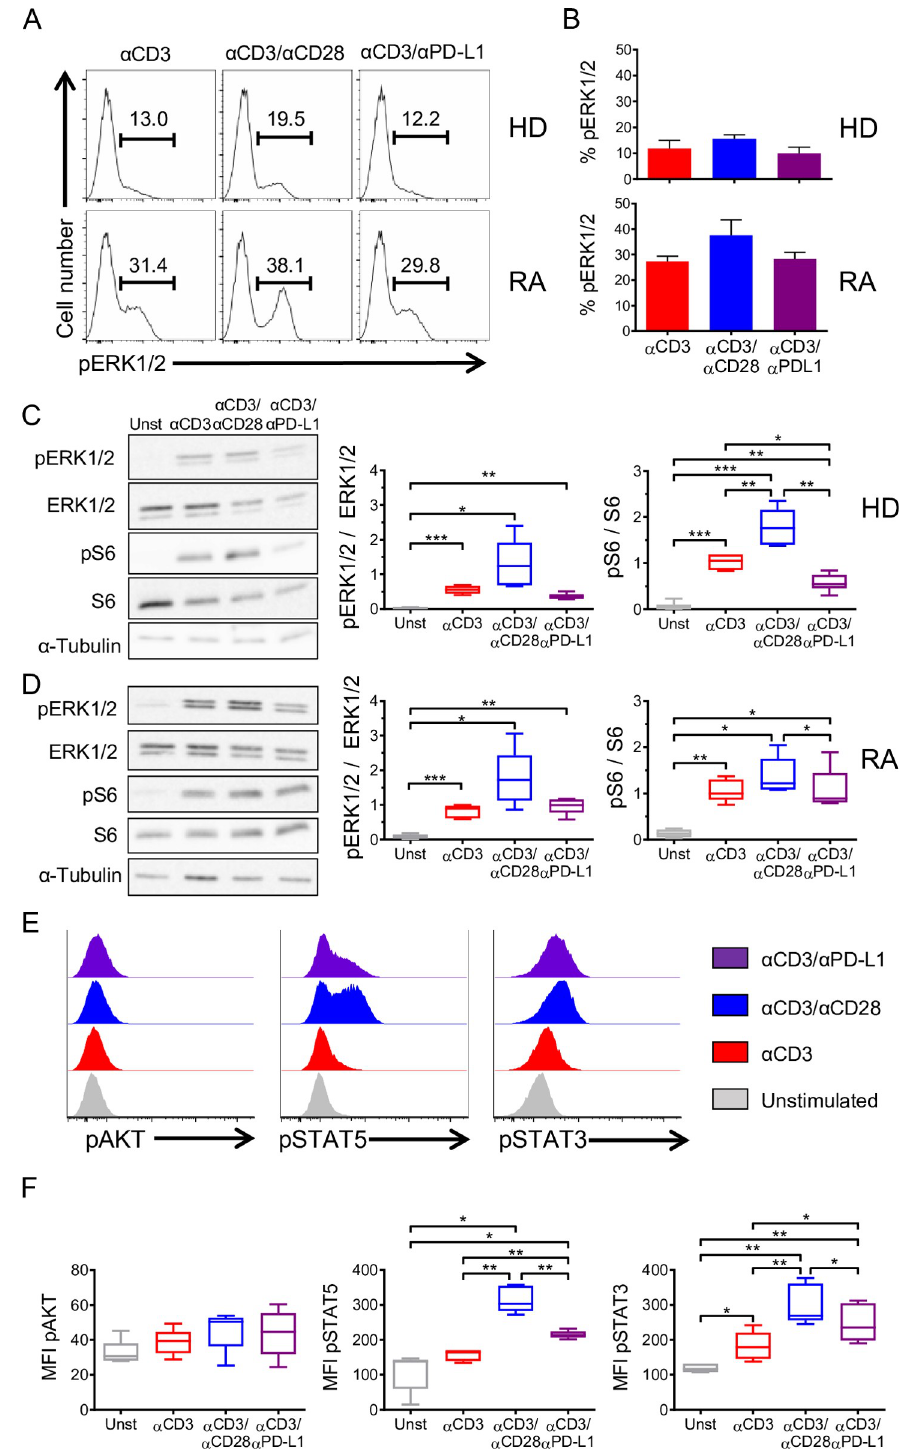
Fig 6. PD-L1 engagement fails to convert CD4 + CD25 − T cells from RA patients into iTreg cells. Representative flow cytometry histograms ( A ) and bar charts ( B ) showing the percentage of pERK1/2 in HDs and RA patients upon the indicated stimulation. ( C ) Representative immunoblot of pERK1/2, ERK1/2, pS6, and S6 in CD4 + CD25 − T cells isolated from HDs upon 15 min of activation under the indicated conditions. α -Tubulin was used as loading control ( n = 6). Data are represented using boxplots indicating the min and max and median; � P < 0.05, �� P < 0.01,